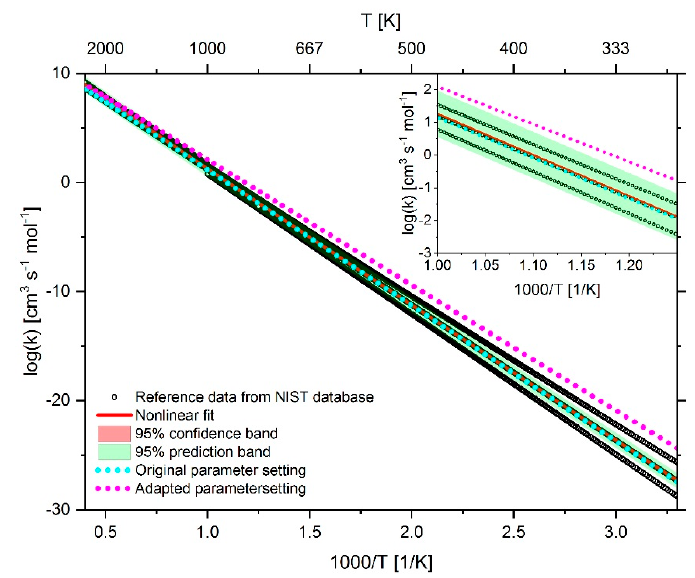
Figure 23. Comparison of the reaction rate coefficient of reaction 44 (CH 4 + O 2 ↔ CH 3 + HO 2 ) before and after adaptation as well as the fitted rate coefficient using reference data from the NIST database.